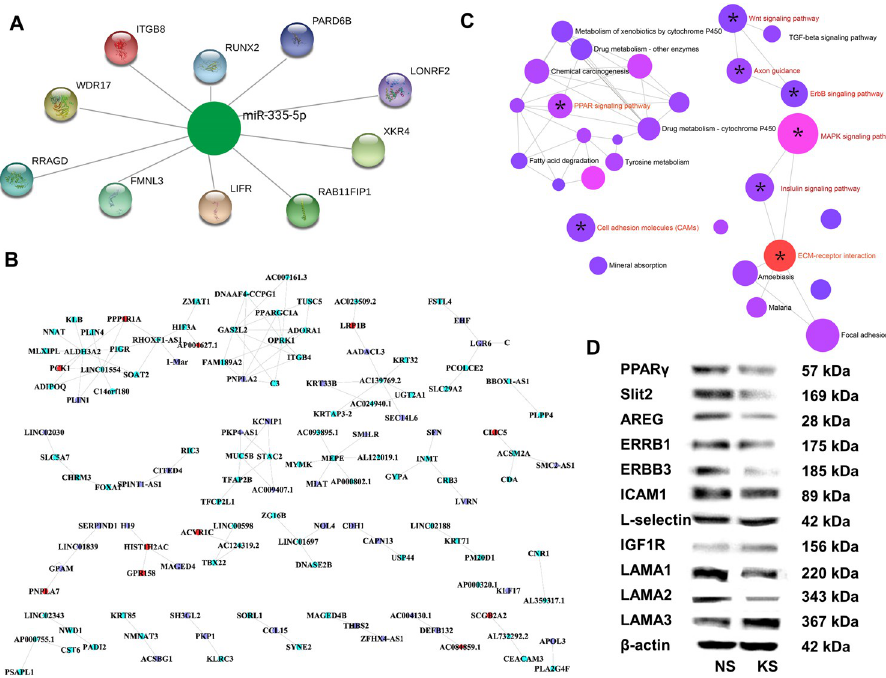
Fig 3. Construction of DERNAs network and verification of enriched signalling pathways. (A) Downregulated hsa- miR-335-5p and its top 10 targeting genes derived from DEmiRNA-target interaction network. (B) RNA interaction network constructed by DEG-DEmiRNA and DEG-DElncRNA interaction pairs from the three WGCNA modules. (C) Identified eight signal pathways enriched from the three modules of the RNA network. (D) Western blot verification of enriched differential signalling pathways between paired keloid tissues and adjacent normal